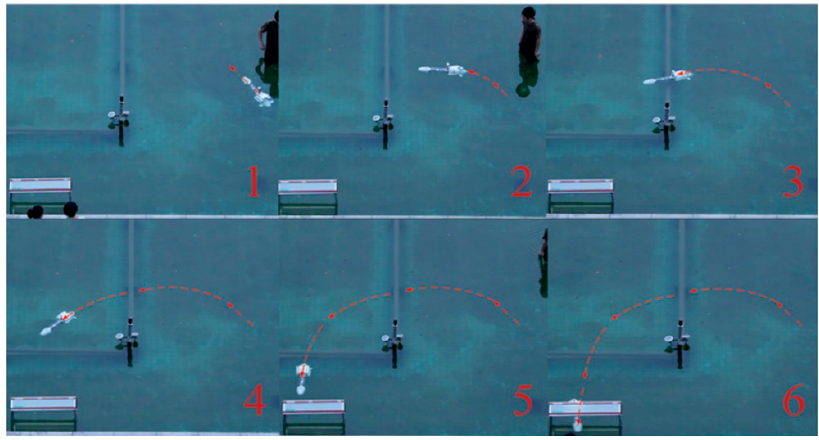
F igure 21. AUV docking test in extreme position.